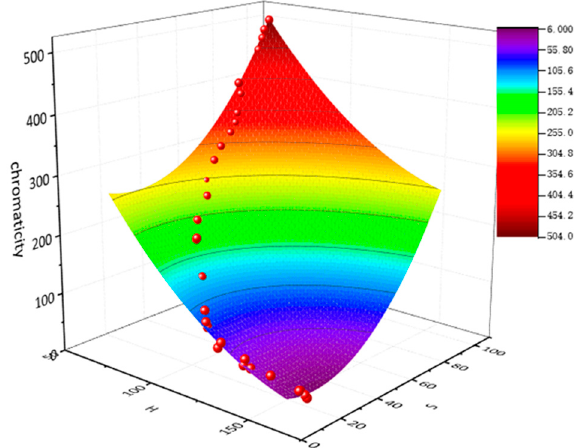
Figure 8. Fitting results of hue (H) and saturation (S) values and chromaticity.